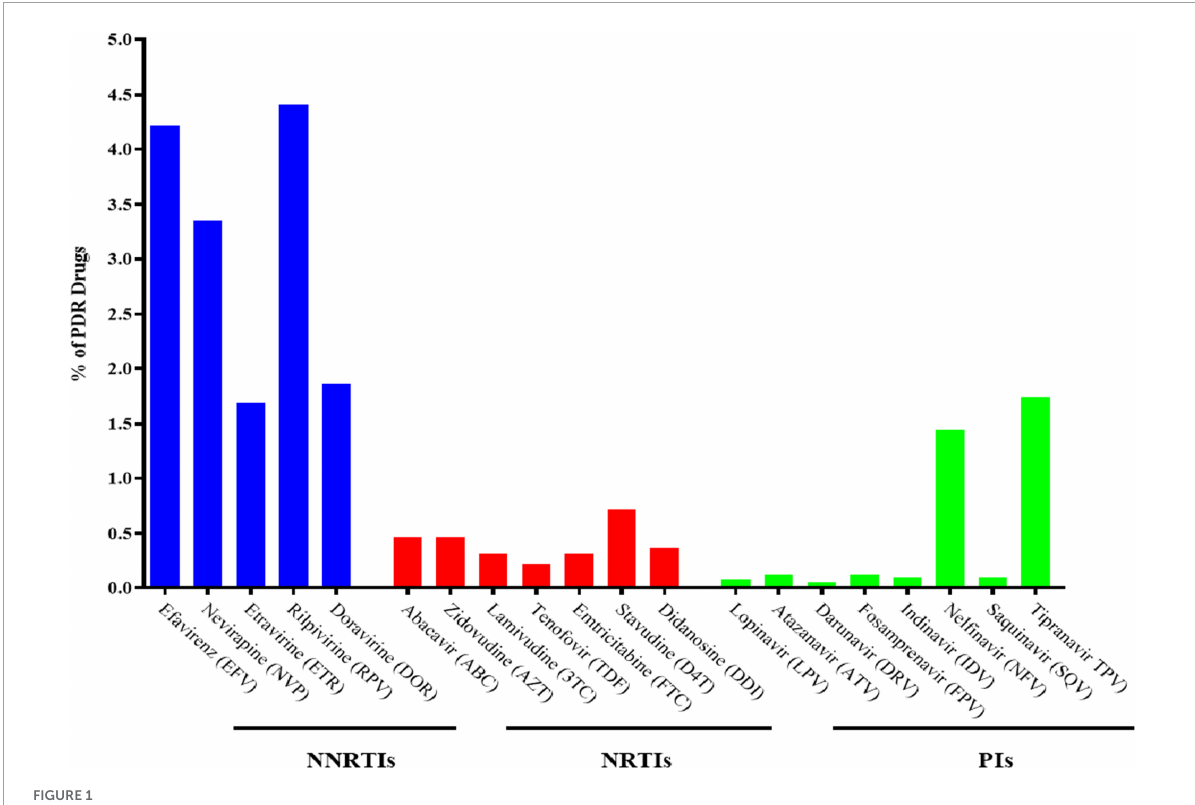
FIGURE1 % of HIV PDR level to different antiretroviral drugs.